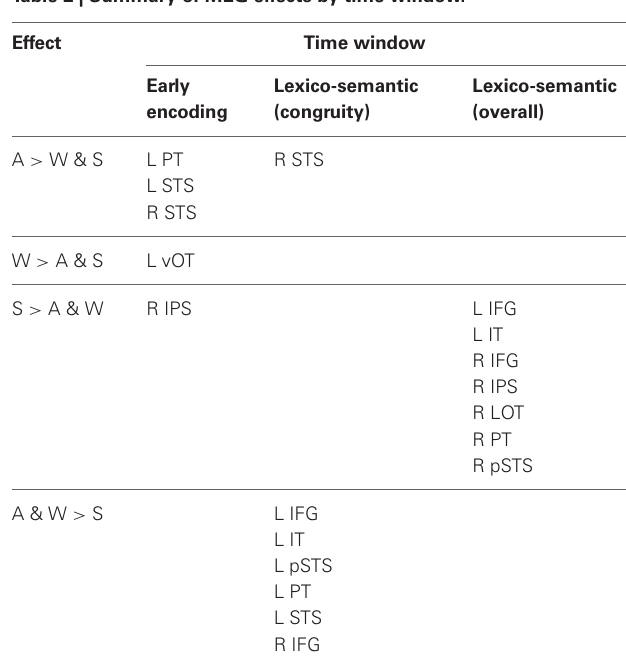
Table 2 | Summary of MEG effects by time